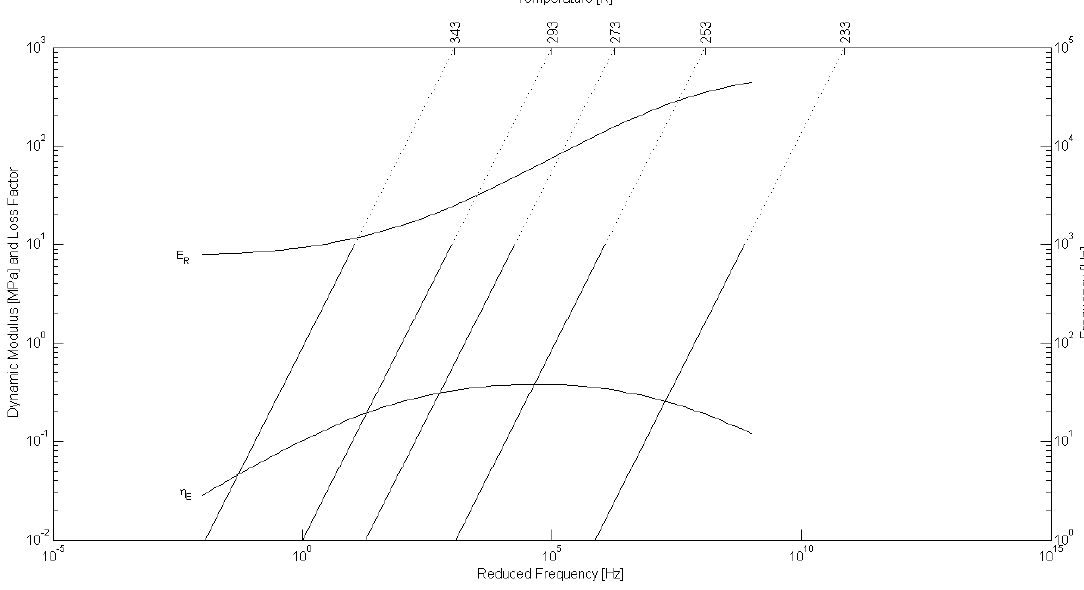
Figure A2. Reduced-frequency nomogram for Butyl Rubber BT 806-55; λ = 0.93 [29].